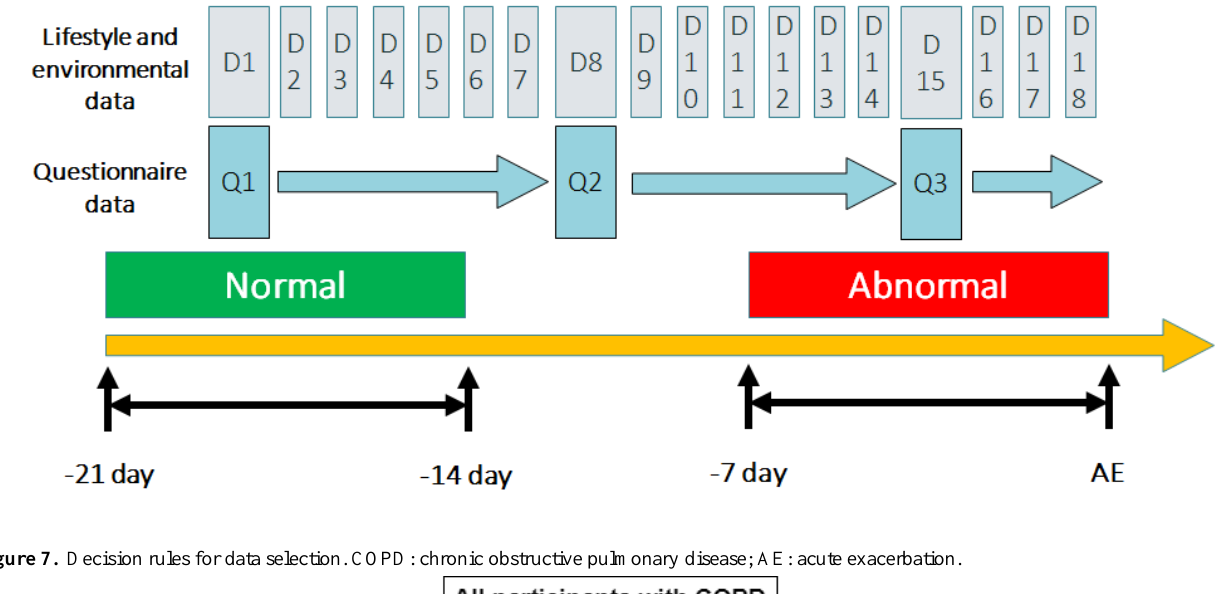
Figure 6. Forward padding for questionnaire data. AE: acute exacerbation.